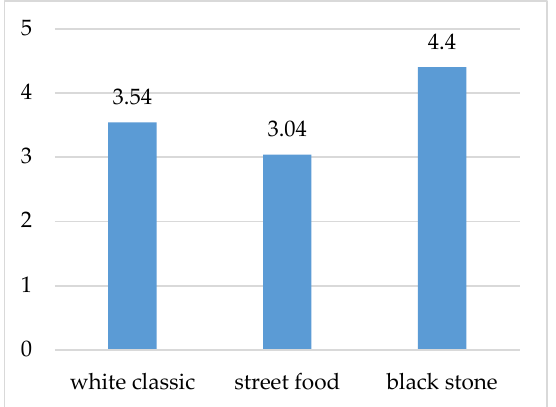
Figure 9. Willingness of respondents to pay for individual waffle designs (average in EUR).